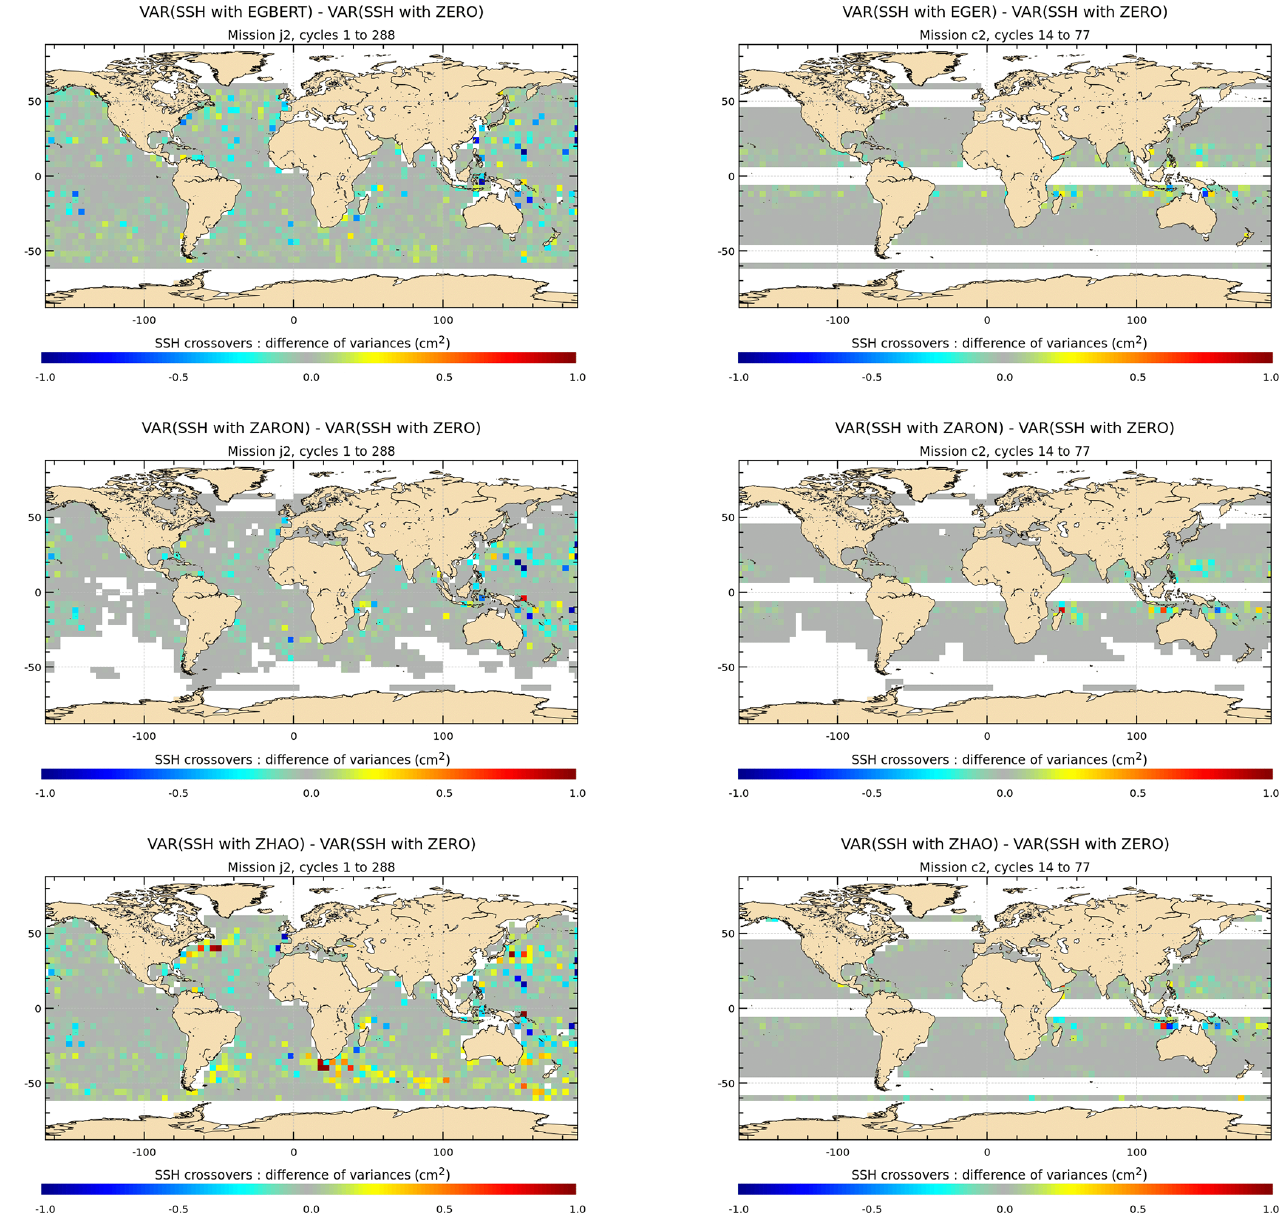
Figure C2. Maps of SSH variance differences at crossovers using either the S 2 IT correction from each model or a reference ZERO correction in the SSH calculation for the J2 and C2 missions (cm 2 ). J2 cycles 1–288 have been used; C2 cycles 14–77 have been